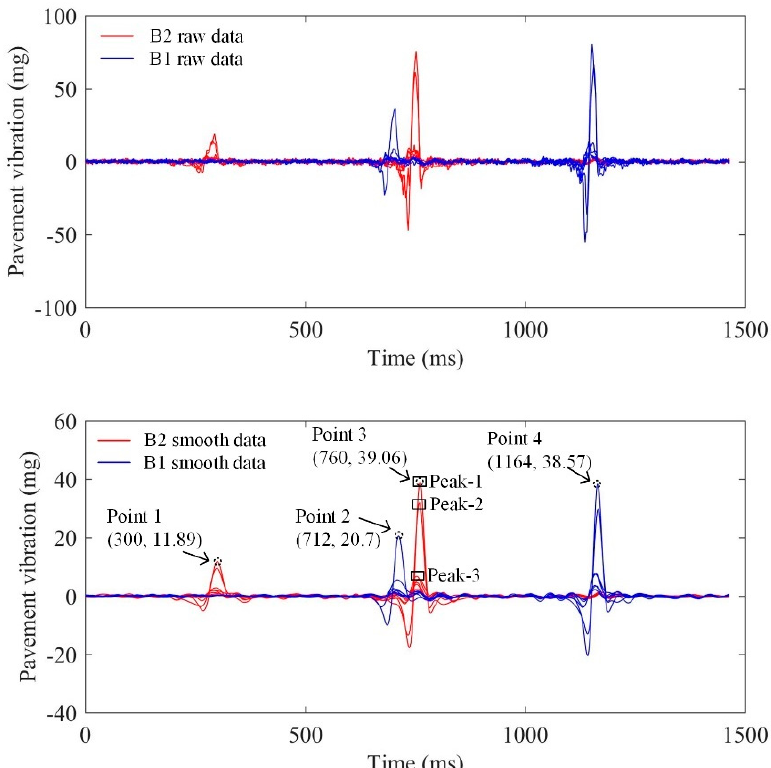
Figure 11. Pavement vibration data of a two-axle vehicle passing through the monitoring area.